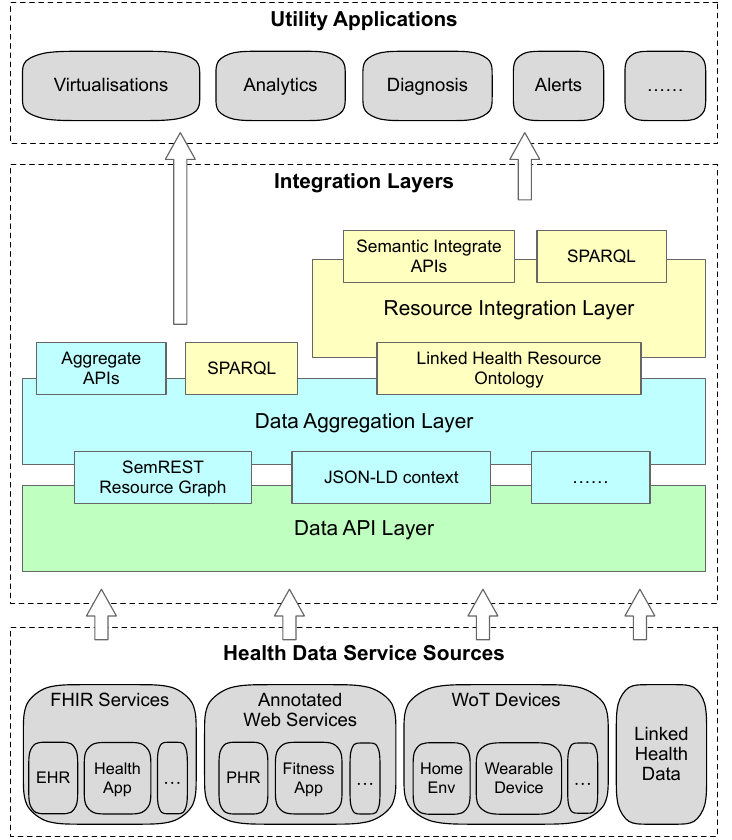
Figure 3. Layered architecture of data integration with the Linked Health Resource. The ontology modeling process works on the resource integration layer, which receives the aggregated resource graph from the data aggregation